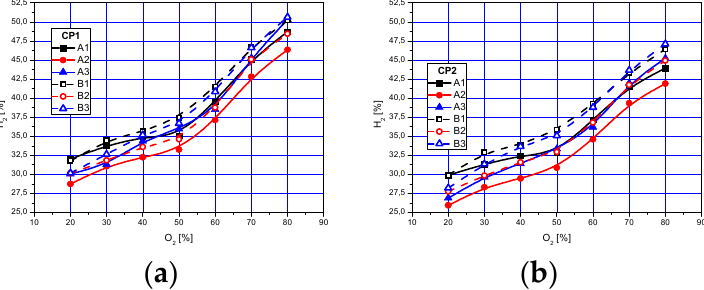
Figure 8. Changes in averaged values of molar fractions of H 2 in the planes CP1 ( a ) and CP2 ( b ) with respect to oxygen concentration for variants A1 , A2 , A3 , B1 , B2 , B3 .